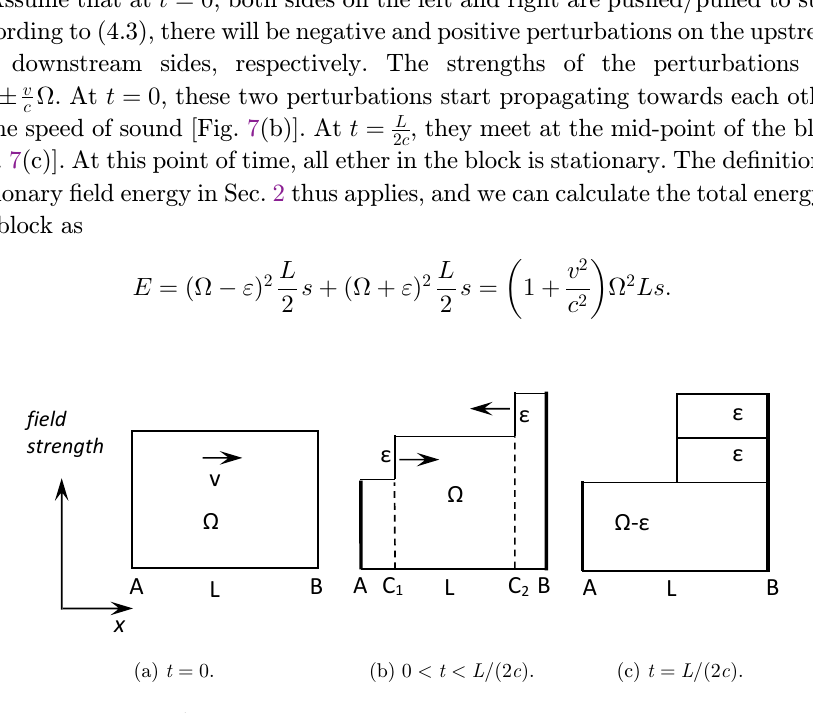
Fig. 7. A block with initial speed is \blocked" to stop on both